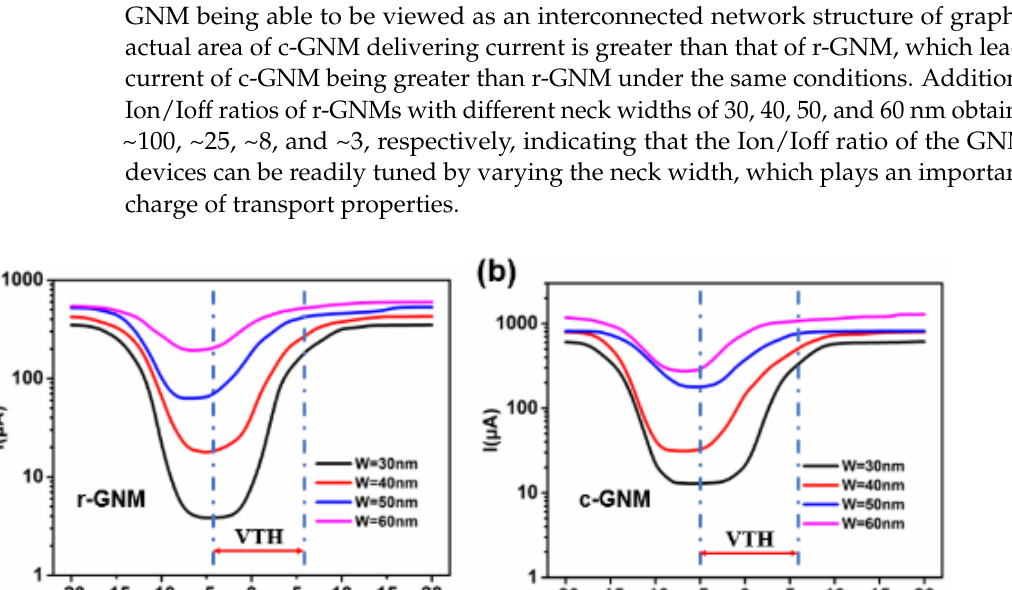
Figure 14. ( a )The terahertz transmission of BPF3.0 ( b ) the curves of the photocurrent of the FET terahertz detector versus the gate voltage. Figure 14b shows that the increase in gate voltage increased the photocurrent, but the increase after the neutral point tends to be saturated. The reason is that the increase in gate voltage will also increase the Fermi energy level, and then affect the carrier concen- tration, so that the excitation of graphene plasmon is weak when the Fermi energy level is relatively low, resulting in a slightly small photocurrent. When the Fermi level increases to a certain extent, the saturation of the terahertz absorption makes the photocurrent no longer increase. In order to further determine the response rate of the graphene nanomesh FET te- rahertz detector, the standard Golay cell GC-1P terahertz detector (TYDEX) was used to